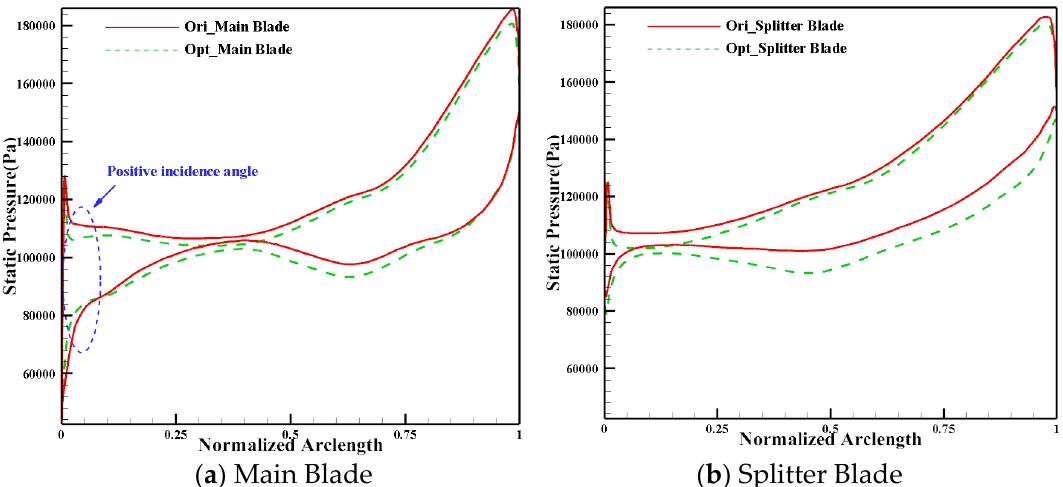
Figure 16. Comparison of the static pressure distribution on the blade surface at 80% height before and after optimisation (Rated operating condition).